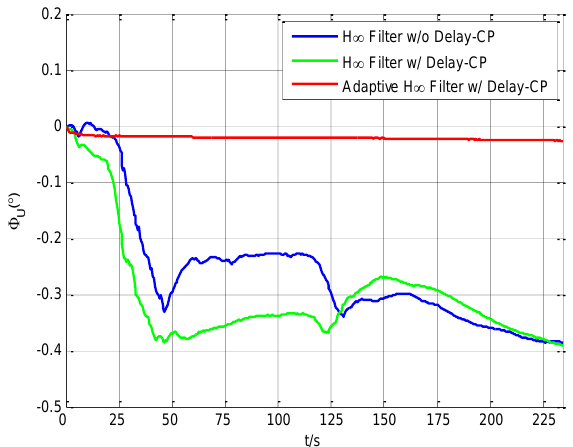
Figure 12. The estimation curves of azimuth misalignment angle.